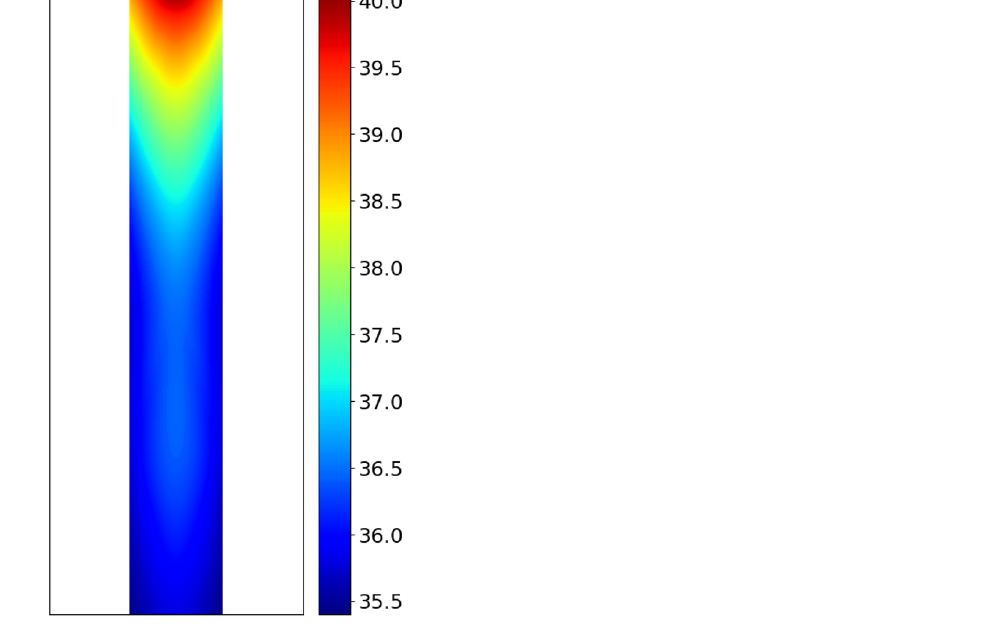
Figure 6. The temperature profile of the solution in the microwave reactor under microwave irradiation. The average temperature is 37 ± 1.3